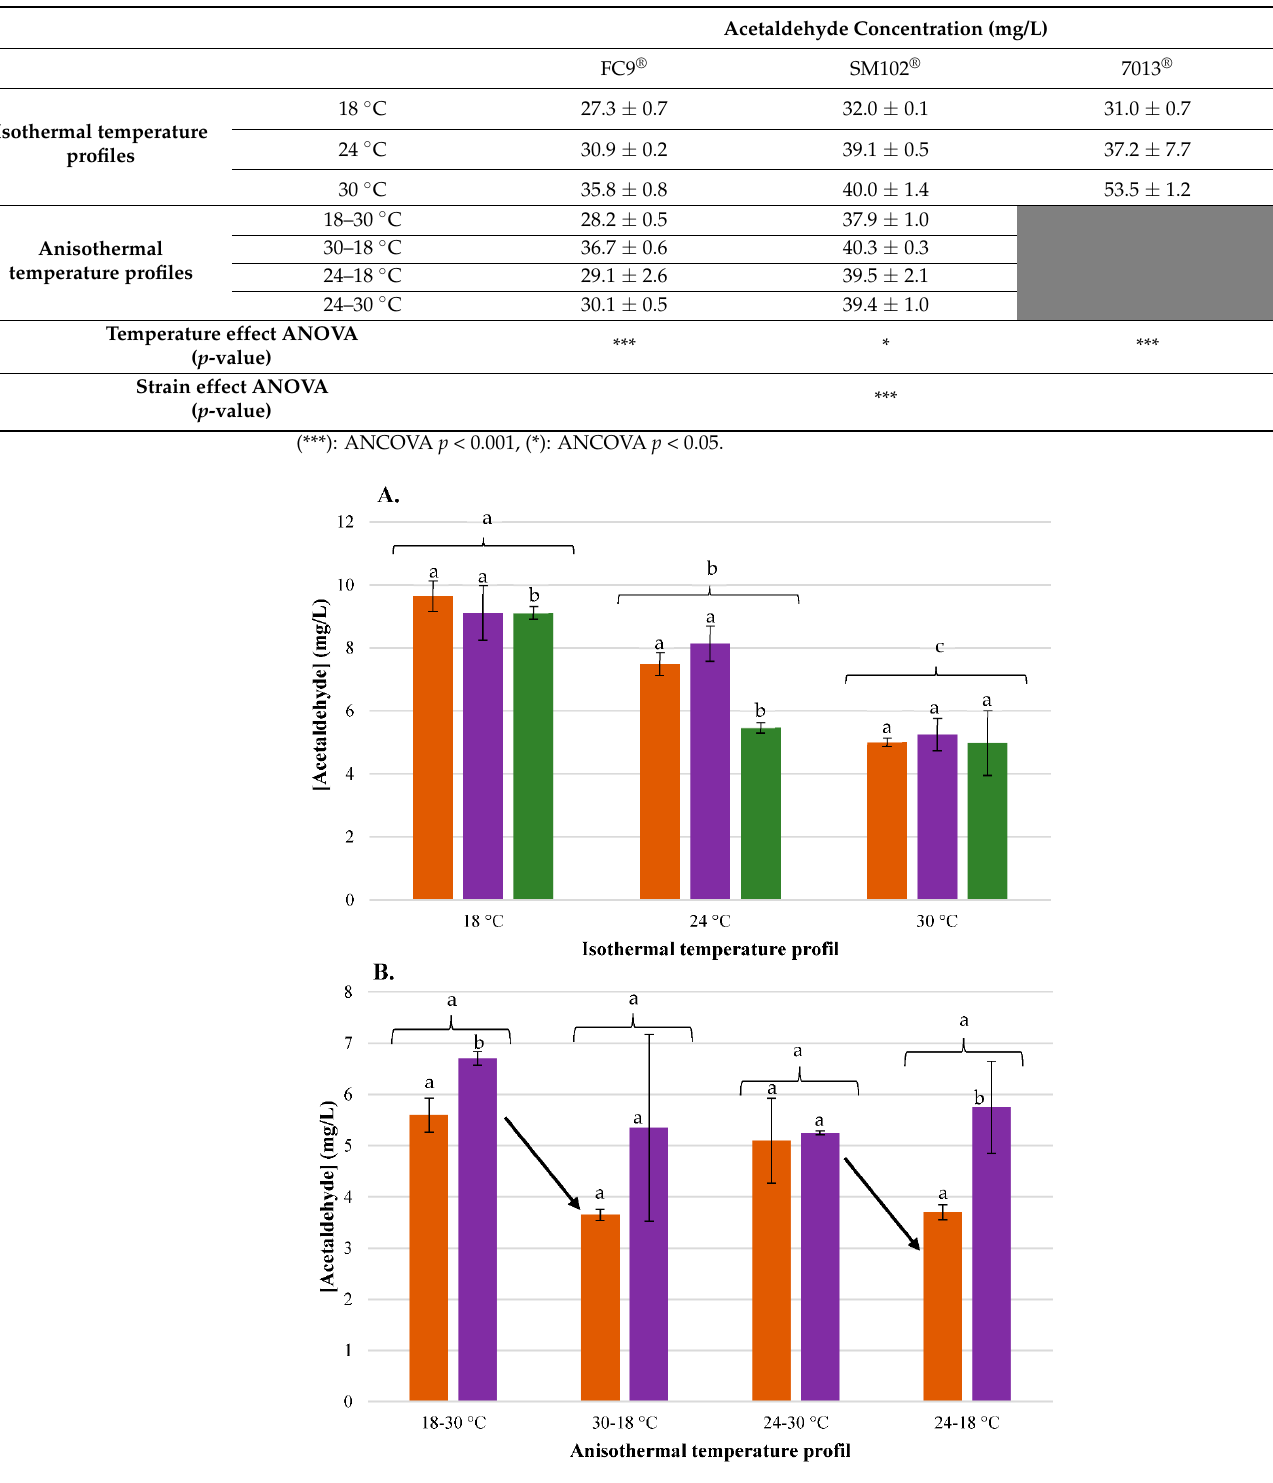
Figure 6. Residual acetaldehyde concentration at the end of alcoholic fermentation for isothermal ( A ) and anisothermal ( B ) temperature profiles with the three yeast strains: FC9 ® (orange), SM102 ® (purple) and 7013 ® (green). The letters (a, b, c) indicate homogeneous groups for acetaldehyde contration at the 95% confidence level, as tested by Tukey’s statistical